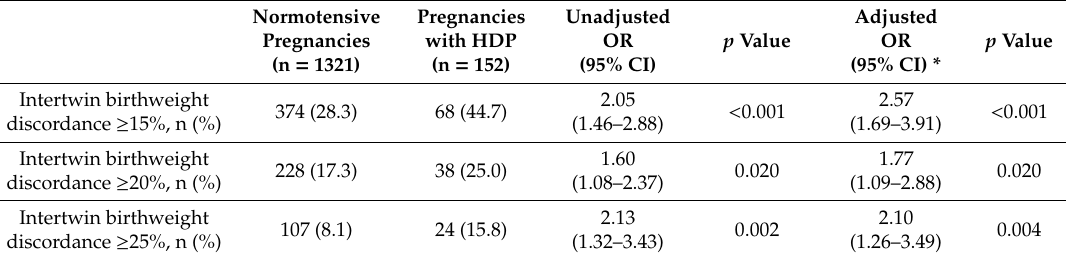
Table 2. The association between intertwin birthweight discordance and